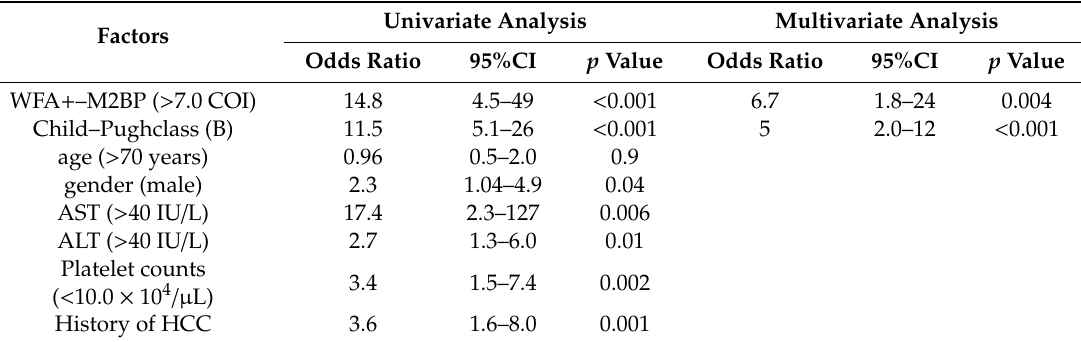
Figure 3. Cumulative incidence of liver related events. Patients were categorized into two groups with the cut-off value for WFA+–M2BP . Table 4. Multivariate analysis for liver related